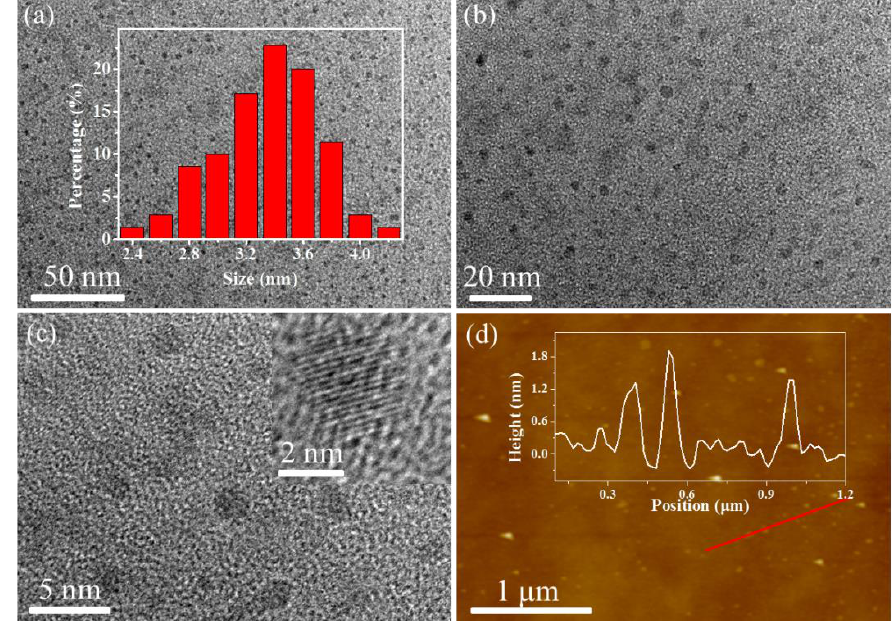
Figure 1. Morphology characterization of high water-solubility molybdenum disulfide quantum dots (WS-MSQDs). ( a – c ) Transmission electron microscope (TEM) images of WS-MSQDs. Inset of ( a , c ): the size distributions and high-resolution (HR) TEM pattern of the WS-MSQDs. ( d ) Atomic force microscope (AFM) image of the WS-MSQDs. Inset of ( d ): height profiles along the red lines in ( d ).